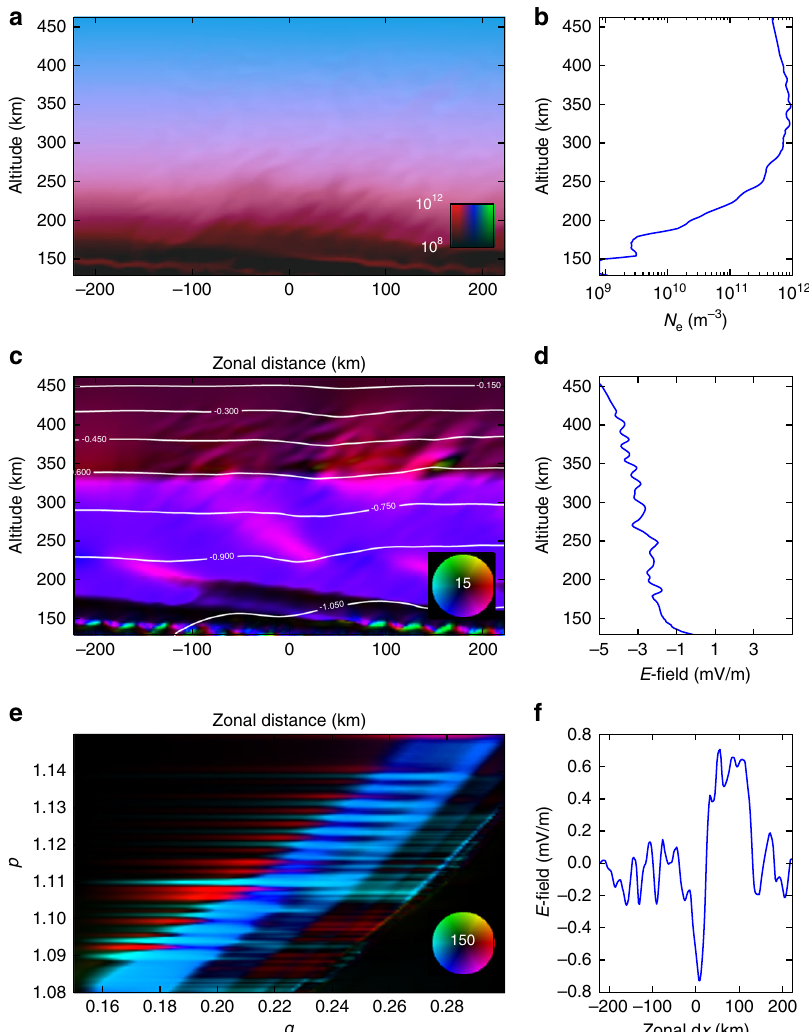
Fig. 5 Results from the ionosphere simulation after 25 min of ionospheric evolution. a Plasma number density, with red, blue, and green hues representing molecular ions, atomic ions, and protons, respectively, in the plane perpendicular to B in a 2D cut through the center of the model volume. b Electron density pro fi le through the center of the top left panel. c Current density in μ A m − 2 according to the color wheel, also in a perpendicular-to- B cut through the center of the model volume. White contours are equipotential curves which are streamlines of the fl ow. d Electric fi eld pro fi le through the center of the middle left panel. e Meridional current density in μ A m − 2 according to the color wheel. f Zonal electric fi eld in the equatorial plane in a cut through the center of the model volume. The color wheels indicate the magnitude and direction of the current density relative to the maximum value of either 15 or 150 nA m − 2 full